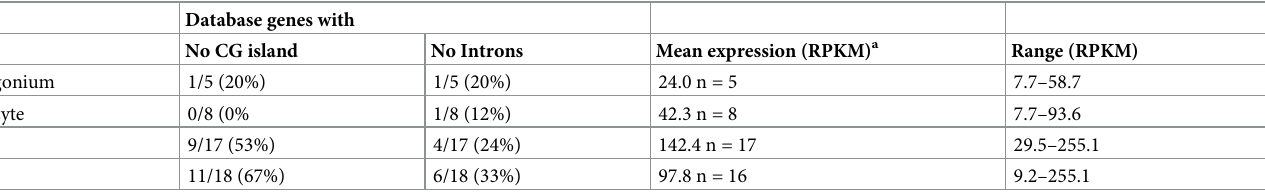
Table 5. Gene expression in sperm lineage